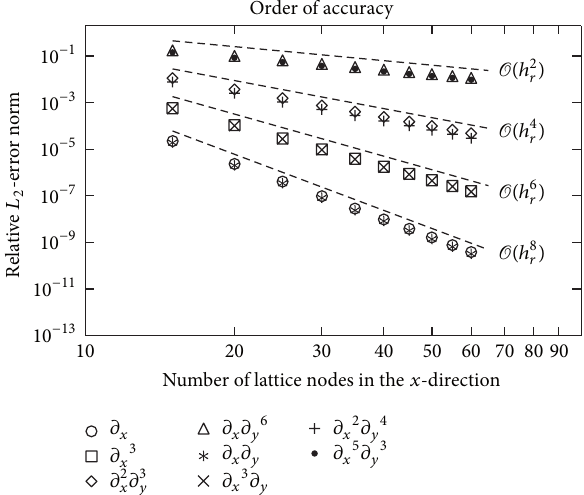
Figure 1: Order of convergence of the numerical error for some derivative approximations. The lattice-Boltzmann stencil D2V141 hasbeenutilized.Thedashedlinesindicate2nd-,4th-,6th-,and8th- order